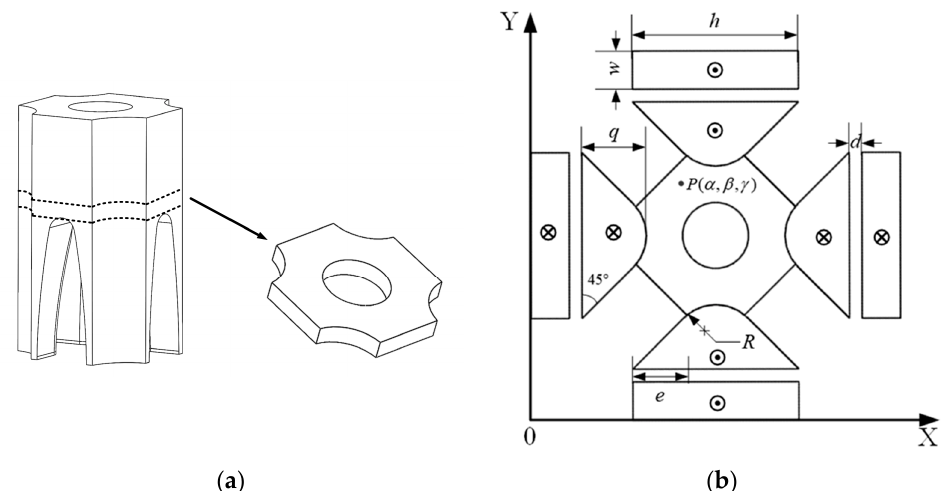
Figure 7. Simplified model of skin effect. ( a ) Simplified model of armature axial direction; ( b ) schematic of parameter annotation.